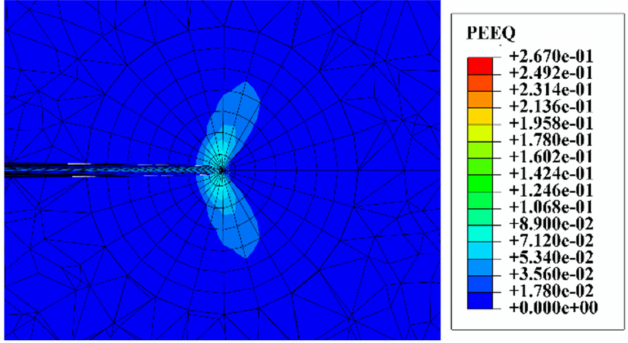
Figure 4. Equivalent plastic strain at the deepest point of the